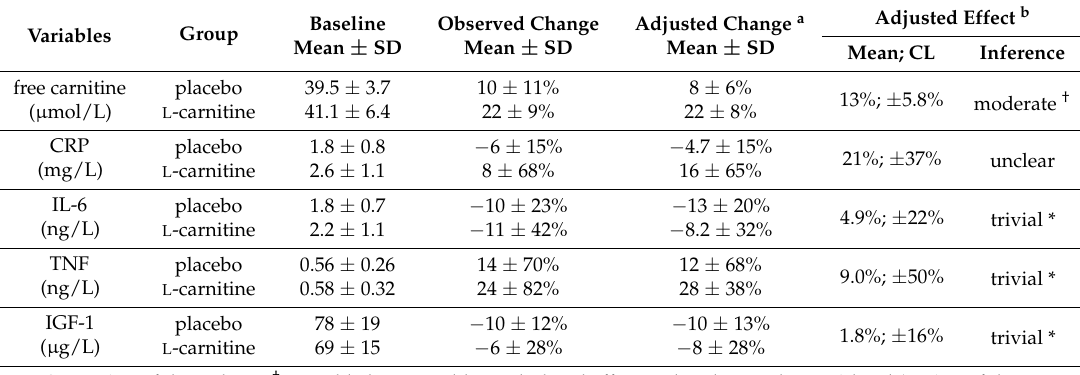
Table 3. Baseline and changes across the supplementation period in both groups and ratios of changes as effects.